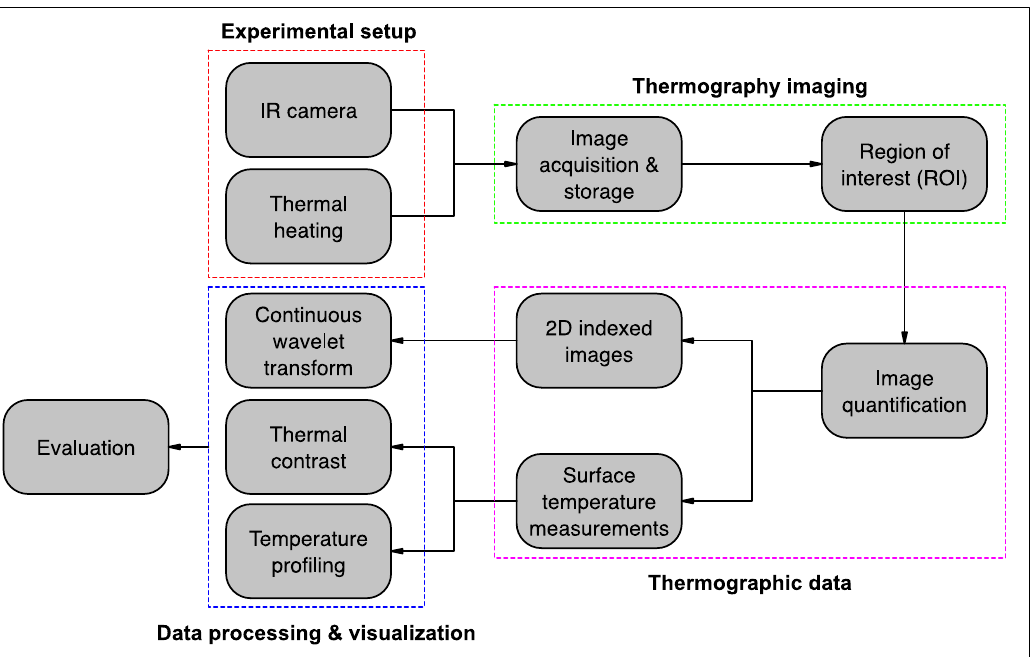
Figure 11. The sequence flow chart of the proposed image-processing methods for the